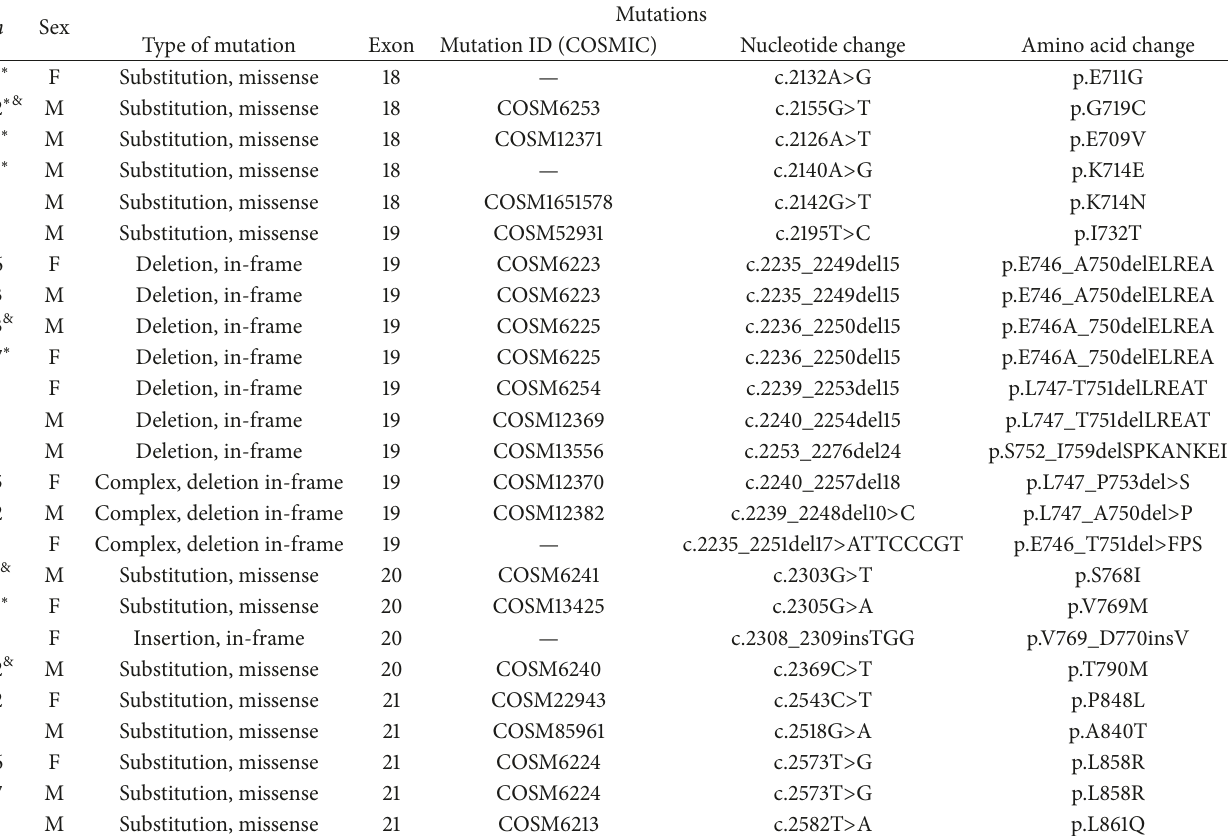
Table 1: Mutations in the EGFR gene.